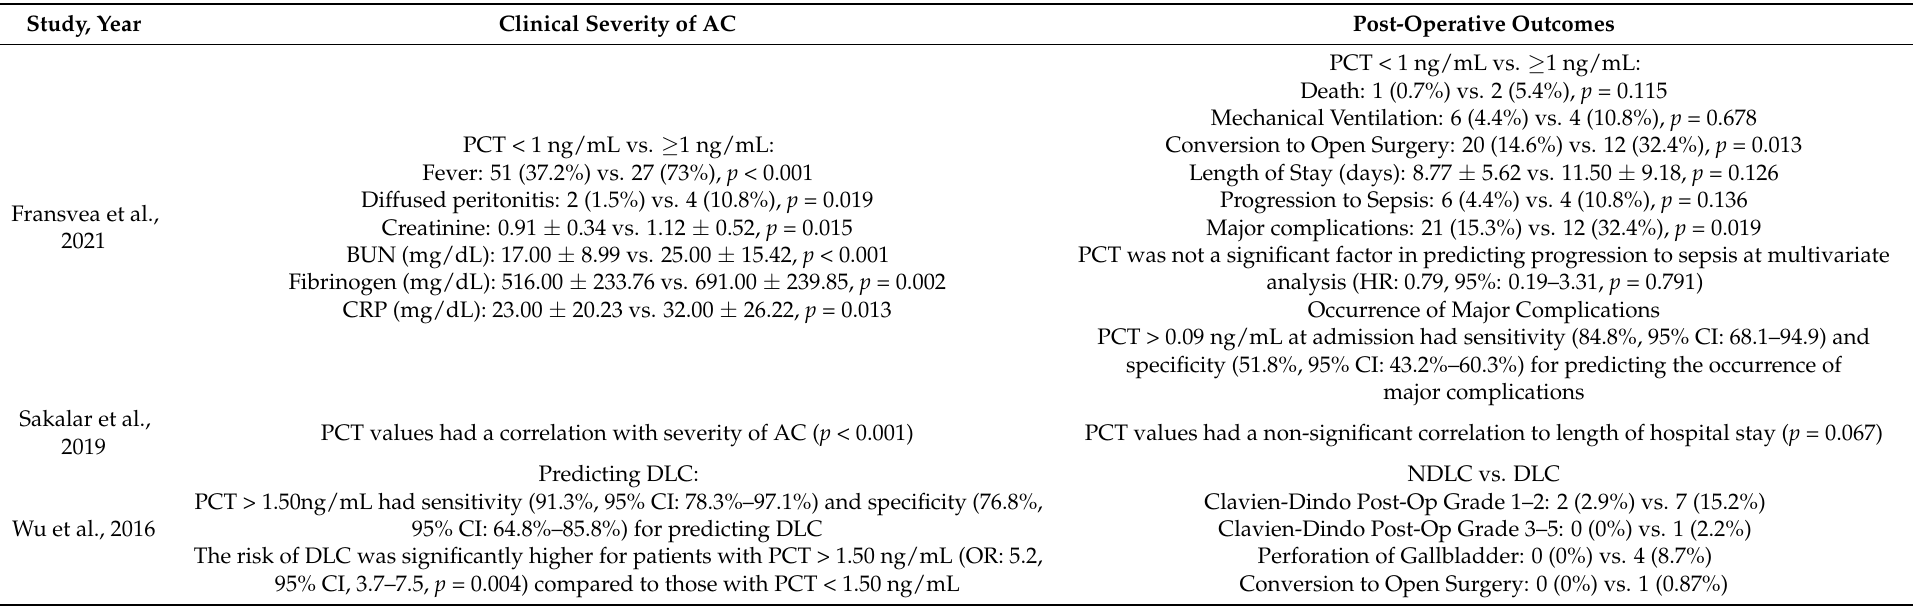
Table 2. Relationship between procalcitonin (PCT) and severity, intra-operative and post-operative outcomes in acute cholecystitis